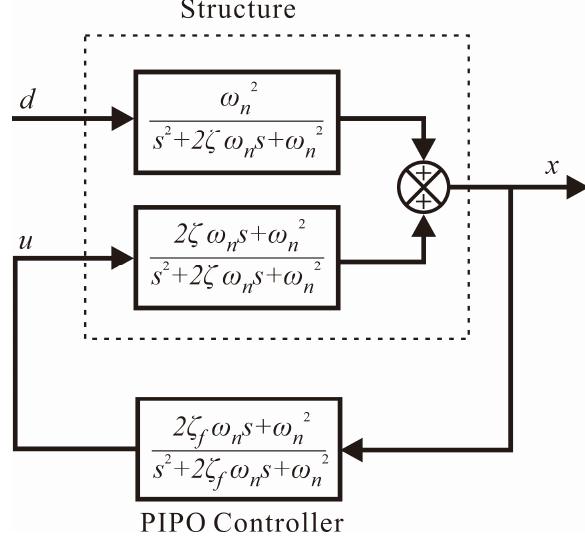
Figure 3. Block diagram of the closed-loop system.